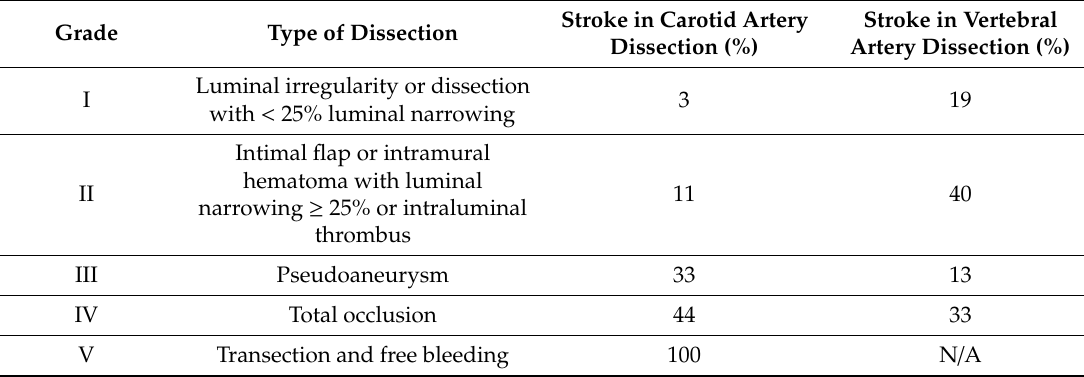
Stroke in Carotid Artery Stroke in Vertebral Dissection (%) Artery Dissection (%)